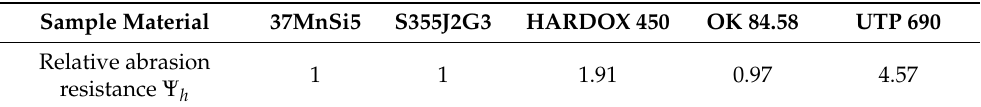
Table 8. Relative abrasion resistance Ψ h